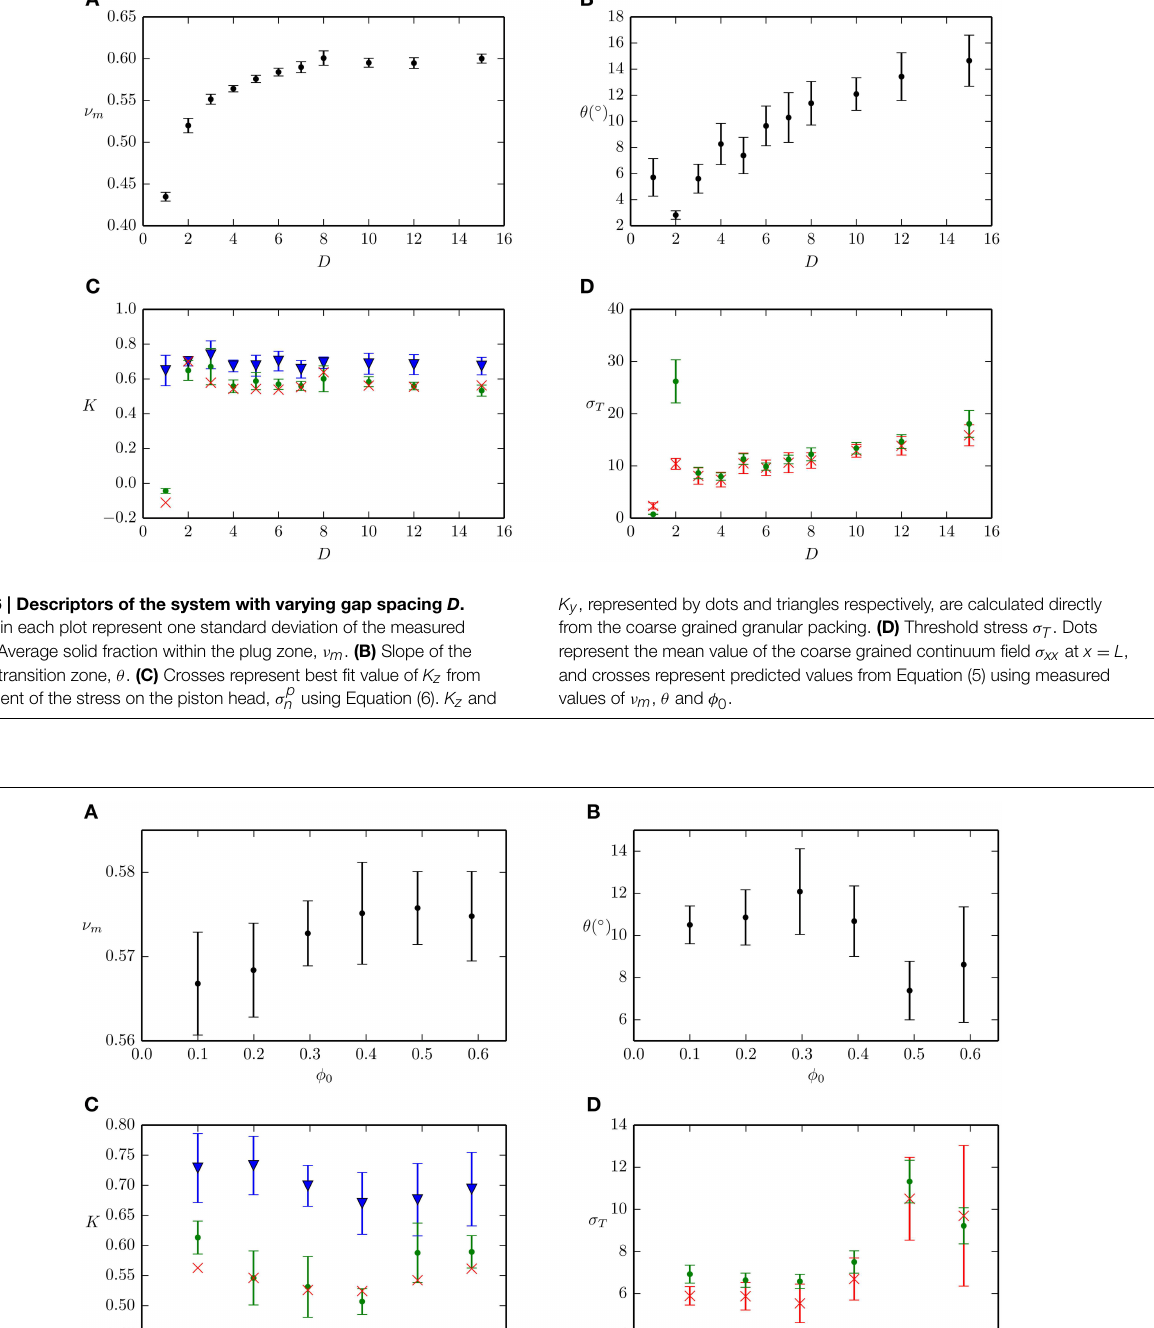
(6). K z and K y , represented by dots and triangles respectively, are calculated directly from the coarse grained granular packing. (D) Threshold stress σ T . Dots represent the mean value of the coarse grained continuum field σ xx at x = L , and crosses represent predicted values from Equation (5) using measured values of ν m , θ and φ 0